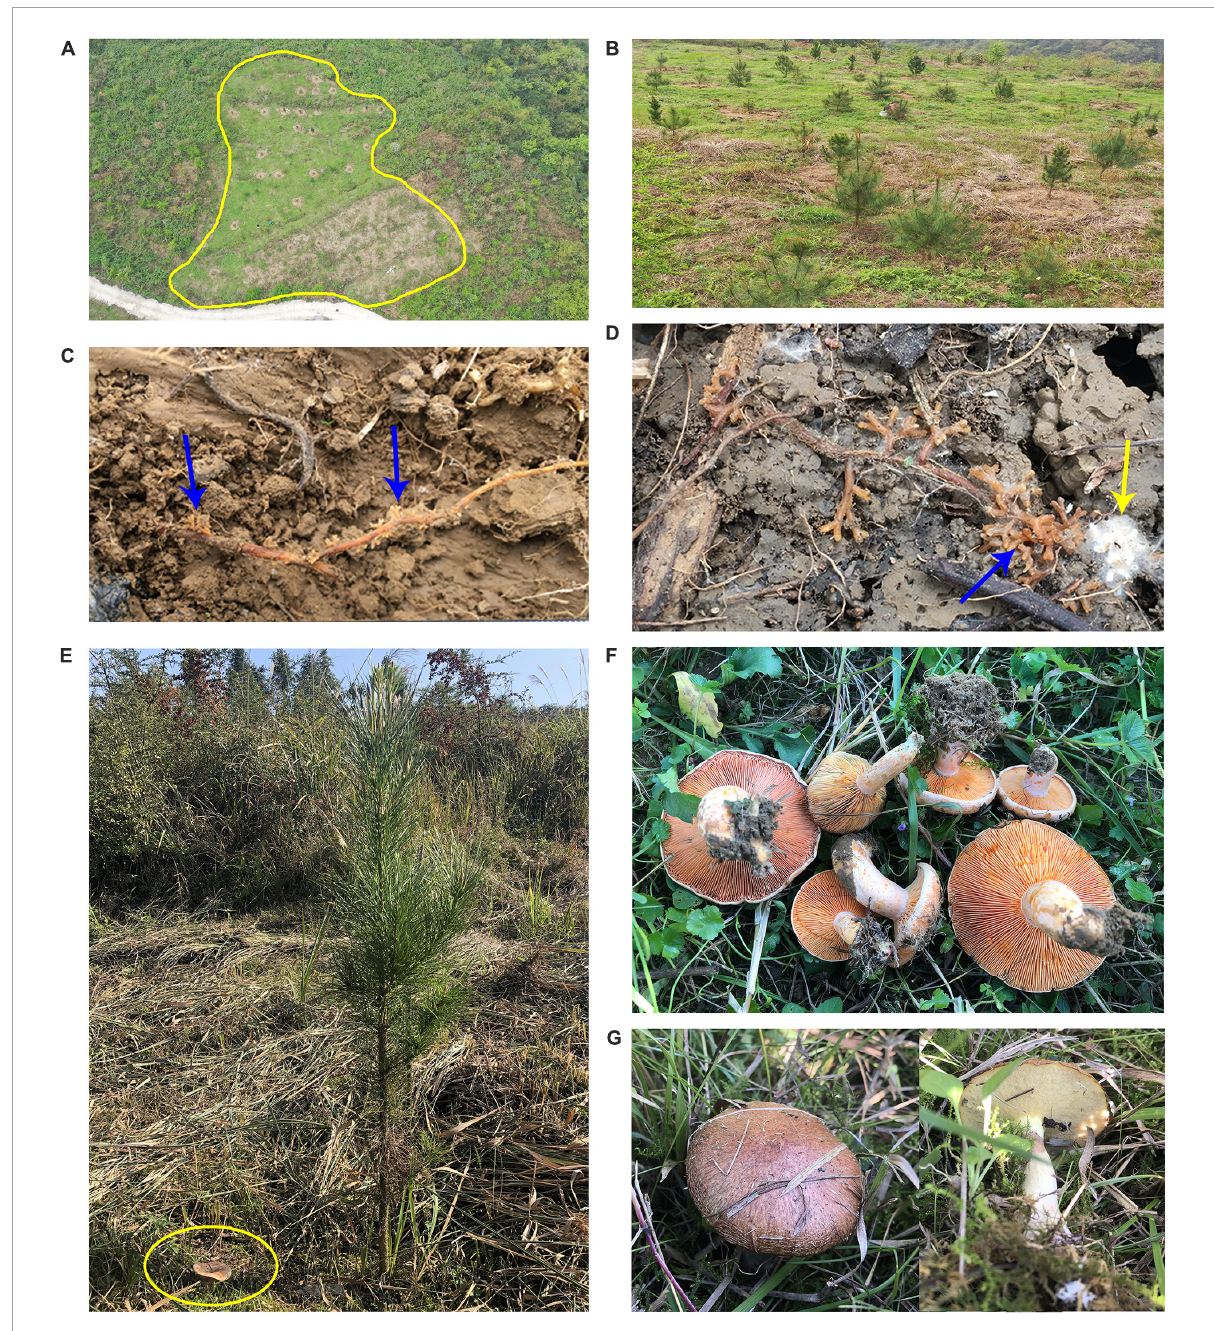
FIGURE1 Plantation in Xifeng and mushroom production in plantation in November 2020. (A) Study site (yellow line). (B) Trees in the plantation 2.5 years after planting, including Pinus radiata + Lactarius deliciosus (PR + LD), P. radiata (PR) and P. massoniana (PM). (C) Ectomycorrhizas of PR + LD (blue arrows showing ECM tips). (D) Suillus colonization to roots of PR + LD (yellow arrow). (E) L. deliciosus fruiting bodies (yellow circle) occurred about one meter from the PR + LD tree. (F) L . deliciosus fruiting bodies from four PR + LD trees. (G) Suillus sp. fruiting bodies occurred near the PR